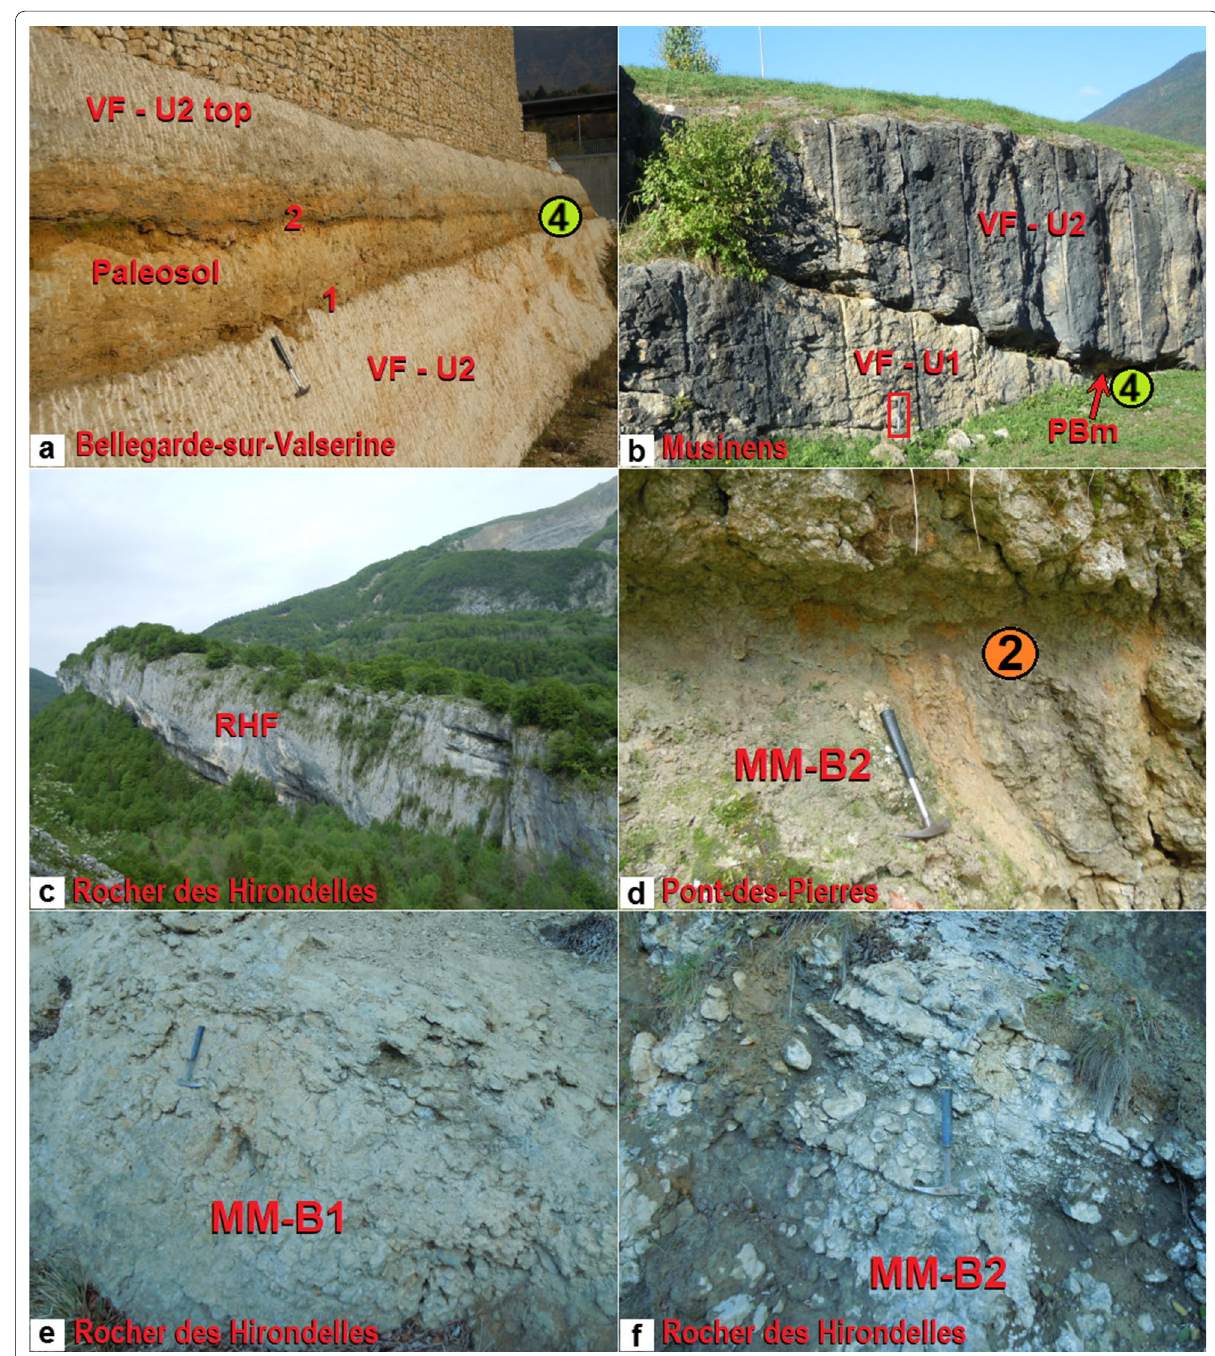
Fig. 9 Sections in the Valserine Valley (southern Jura Mountains). a Bellegarde‑sur‑Valserine railway station section, upper Vallorbe Formation with yellow–brown paleosol marked by molds of rootlets and two layers of brackish/lacustrine marls (1, 2) characterized by Late Barremian microfossils (charophytes, ostracods). b Musinens section, upper Vallorbe Formation with oblique irregular paleokarst surface (between U1 and U2) and Late Barremian marly infilling (marls of Poet Beds) with orbitolinids and marine ostracods. c Rocher des Hirondelles section with steep cliff of thick massive Rocher des Hirondelles Formation (RHF). d Pont‑des‑Pierres section, dark shallow and bioturbated marly limestones (B2) with limonite, detrital quartz and Early Barremian ostracods. e , f Basal Rocher des Hirondelles section with nodular and pseudoconglomeratic marly limestones (B1, B2) at the northern tunnel entry (D991 Road). Captions: VF: Vallorbe Formation; U1–U2: units of the upper Vallorbe Formation (cf. Pictet et al., 2016, 2019); PBm: marls of Poet Beds; MM: Montcherand Member; B1–B2: Early Barremian deeply bioturbated and brecciated deposits (B1: lower layer; B2: upper layer). For the reported ostracod assemblages (colored circles 2, 4), see Figs. 10 and 11. The hammers are 31.5 cm ( a , b : red frame; d